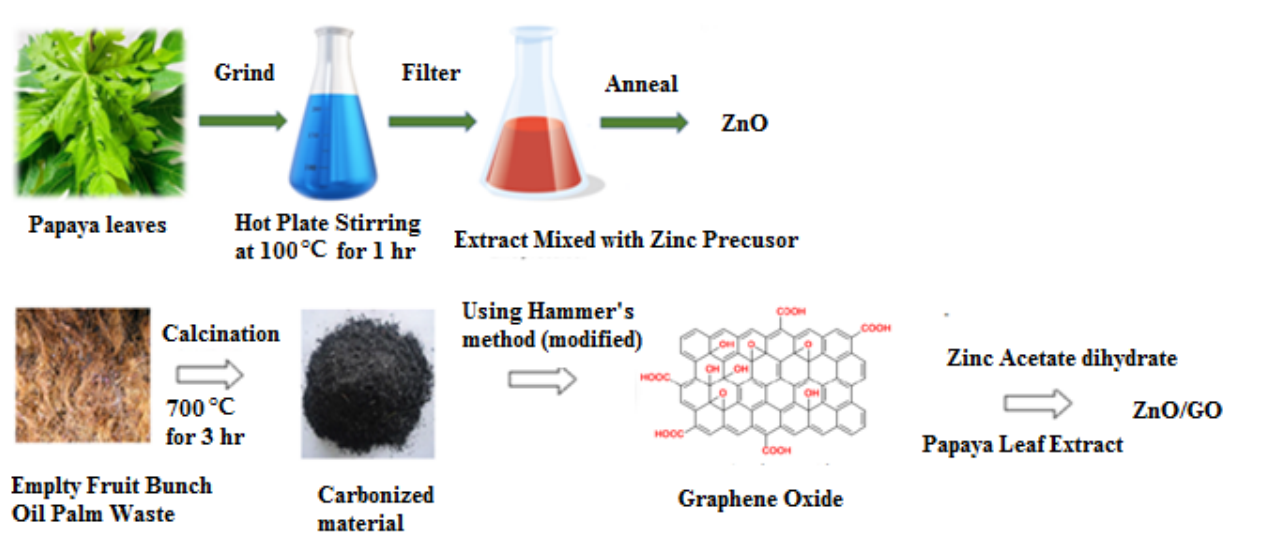
Figure 11. A systematic diagram showing the green synthesis method for ZnO and ZnO/GO.